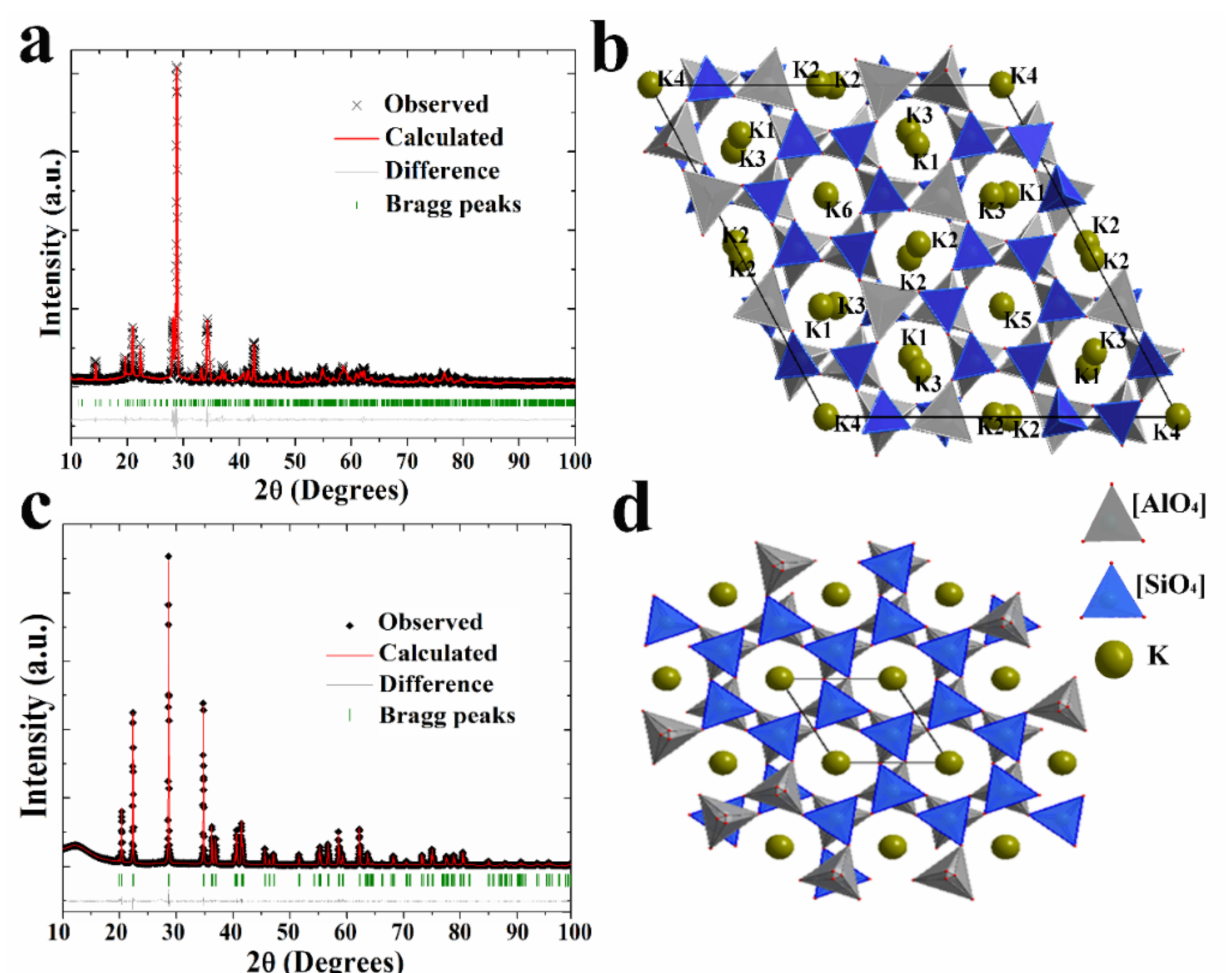
Figure 3. ( a , c ) Experimental, calculated XRD patterns and their difference for the Rietveld fits of MEK and kalsilite using the GSAS program; ( b , d ) the crystal structure of MEK and kalsilite based on the refinement